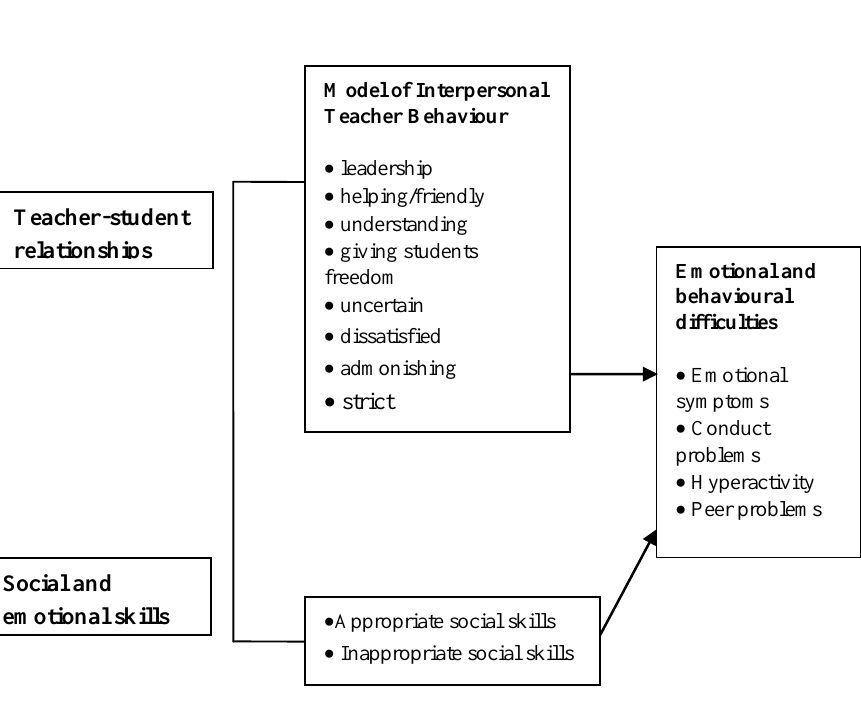
Figure 1. Hypothesized model exploring the relationships between teacher-student relationships and social and emotional skills with emotional and behavioural